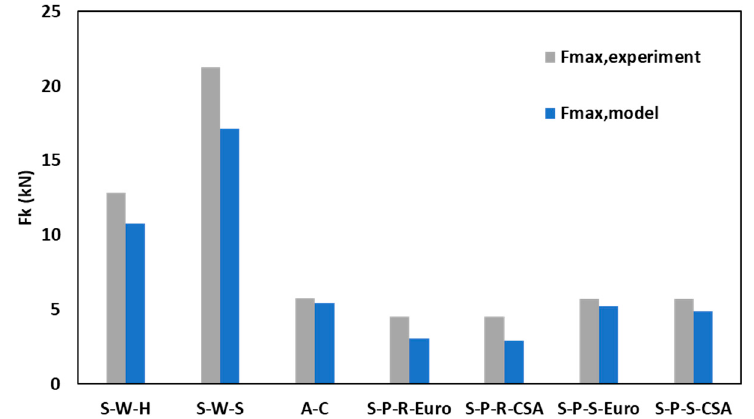
Figure 30. Comparison between the experimental and theoretical results in terms of capacity *.